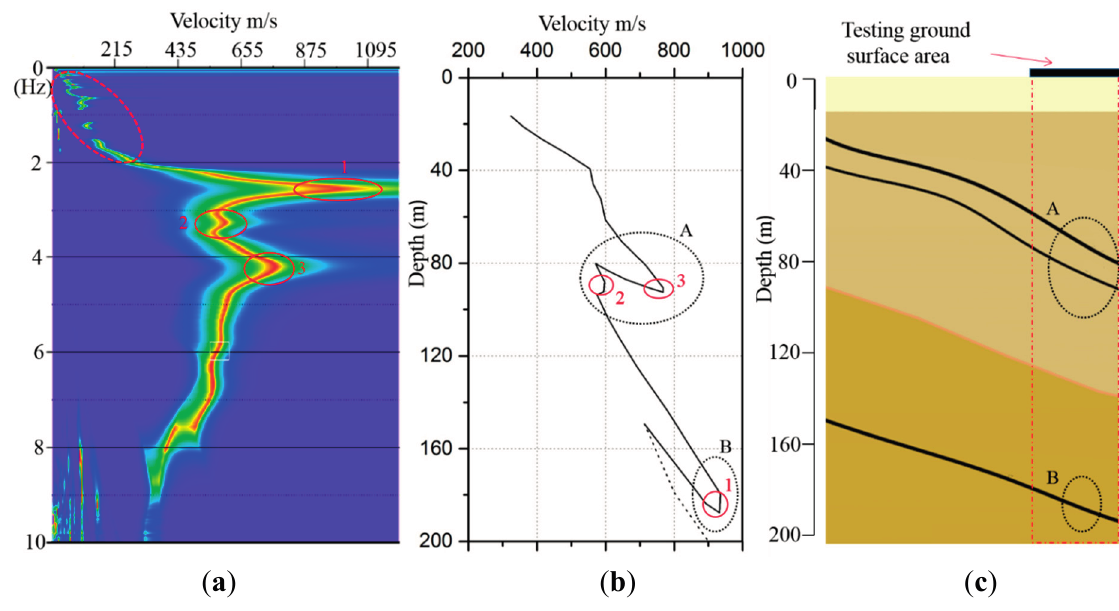
Figure 14. Coal layer estimation: ( a ) dispersion image; ( b ) velocity profile; and ( c ) geological profile